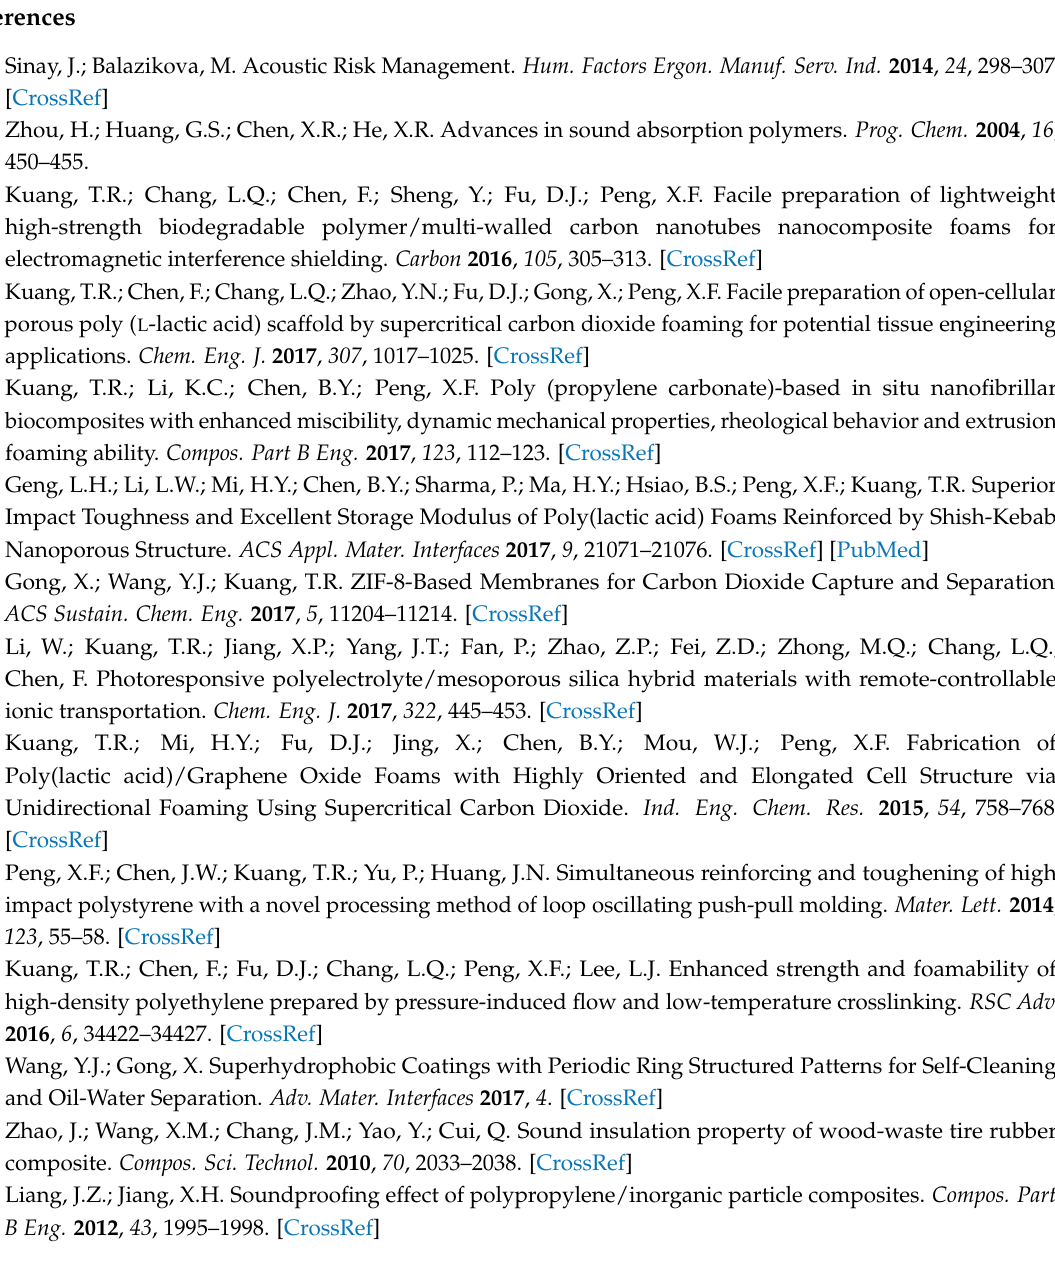
Figure S1: The average STL value of different TPE composites, Table S1: Mechanical and acoustic parameters of different TPE composites, Figure S2: Cut-away diagram of the transmission loss tube, Figure S3: The loss factor curves of TPR materials with different EPDM content, Figure S4: The loss factor curves of (a) TPR/CaCO3 and (b) TPR/HGM